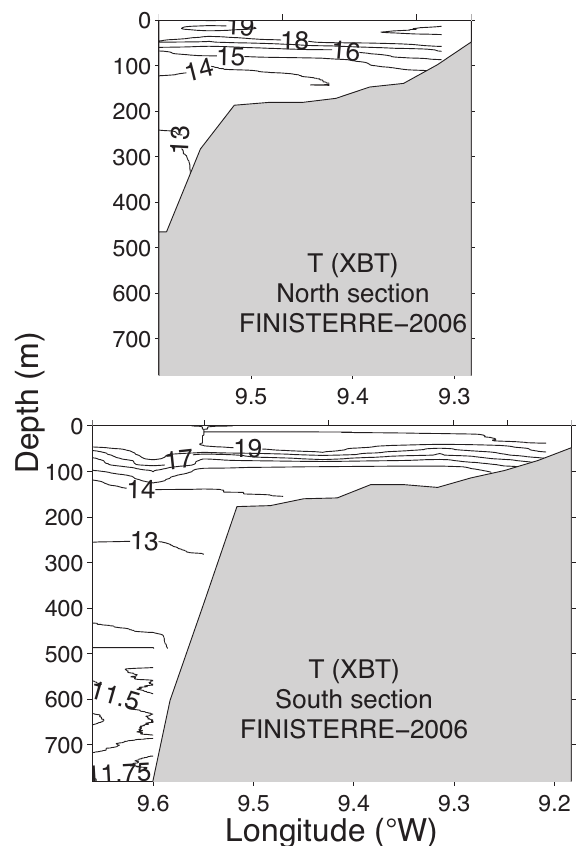
Fig . 12. – Vertical sections of temperature measured by XBTs dur- ing the FINISTERRE-2006 field exercise in the northern and south- ern sections as a function of longitude.